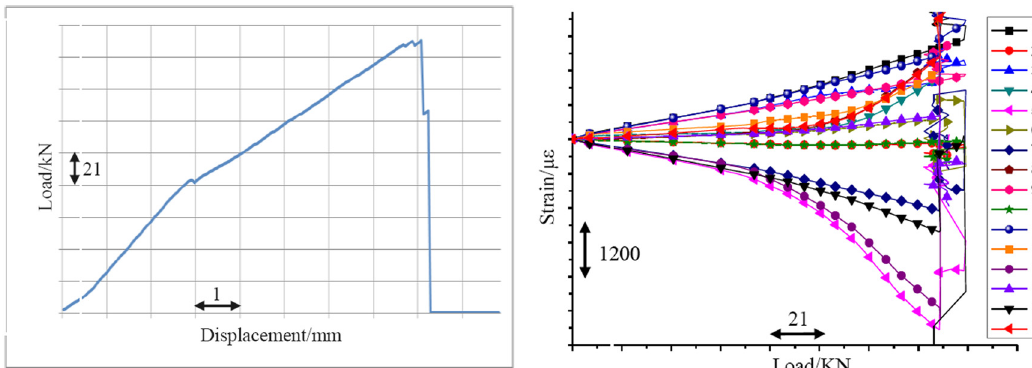
Figure 4: a2 - type test